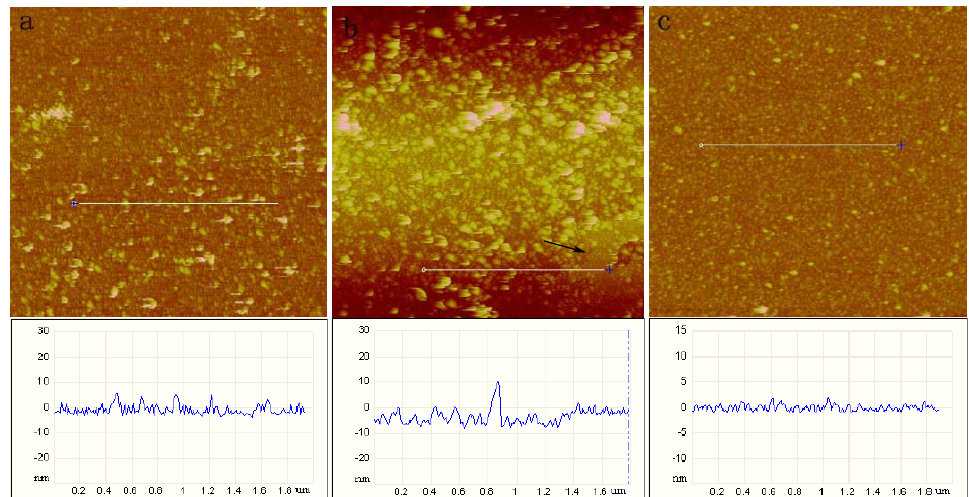
Figure 1. AFM height images (image size 3 × 3 μ m 2 ) of small unilamellar vesicles (SUVs, filtered by 100 nm polycarbonate membrane) and their corresponding section analyses after incubation of a silicon wafer in a vesicle solution (0.2 mg/mL) for (a) 10 min, (b) 30 min, and (c) 60 min respectively.